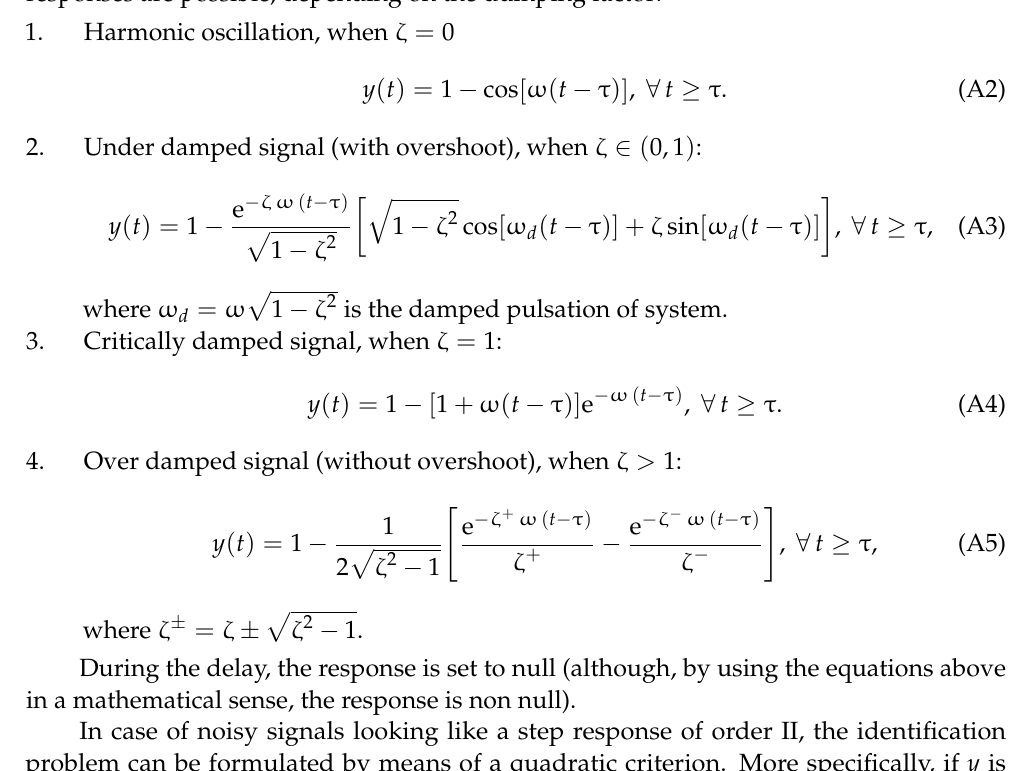
Figure A1. Quadratic criterion surfaces in identification of second order step